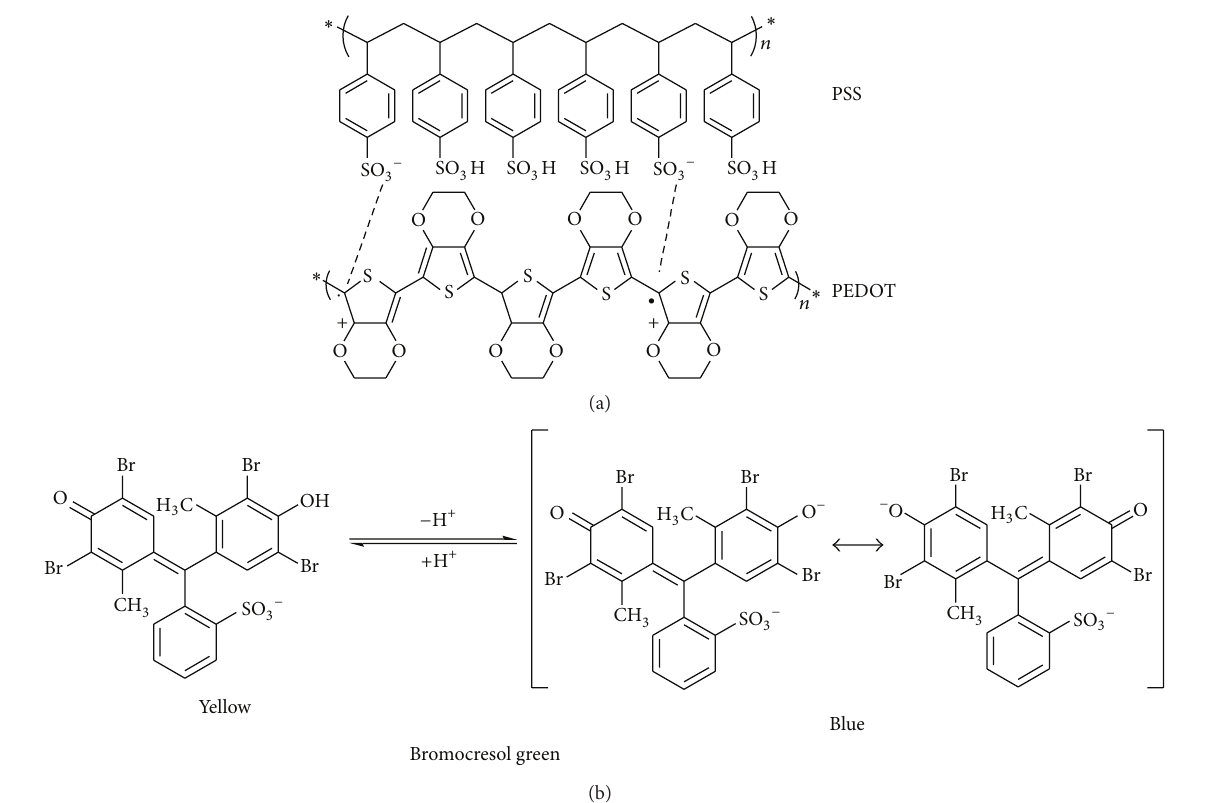
Figure 1: Molecular structures of (a) PEDOT:PSS and (b) bromocresol green